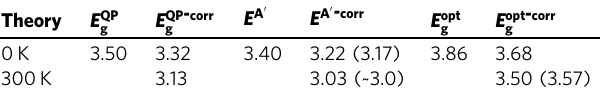
Table 3 Indirect QP gap, E QP 0 K and optical gap, E opt